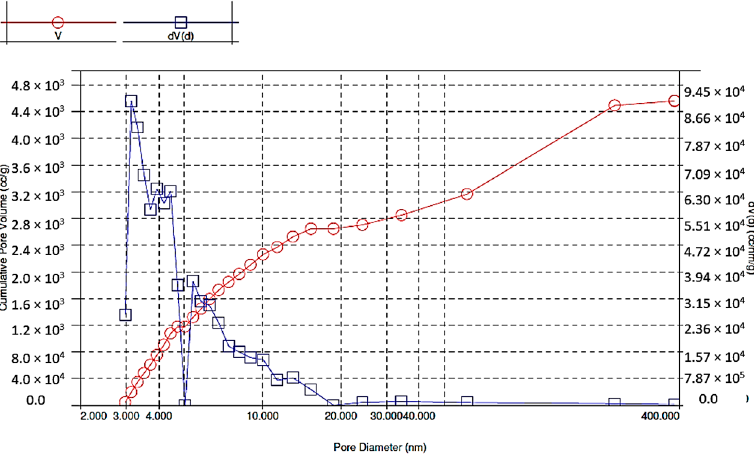
Figure 6. Pore size distribution in brewer’s grains during desorption.